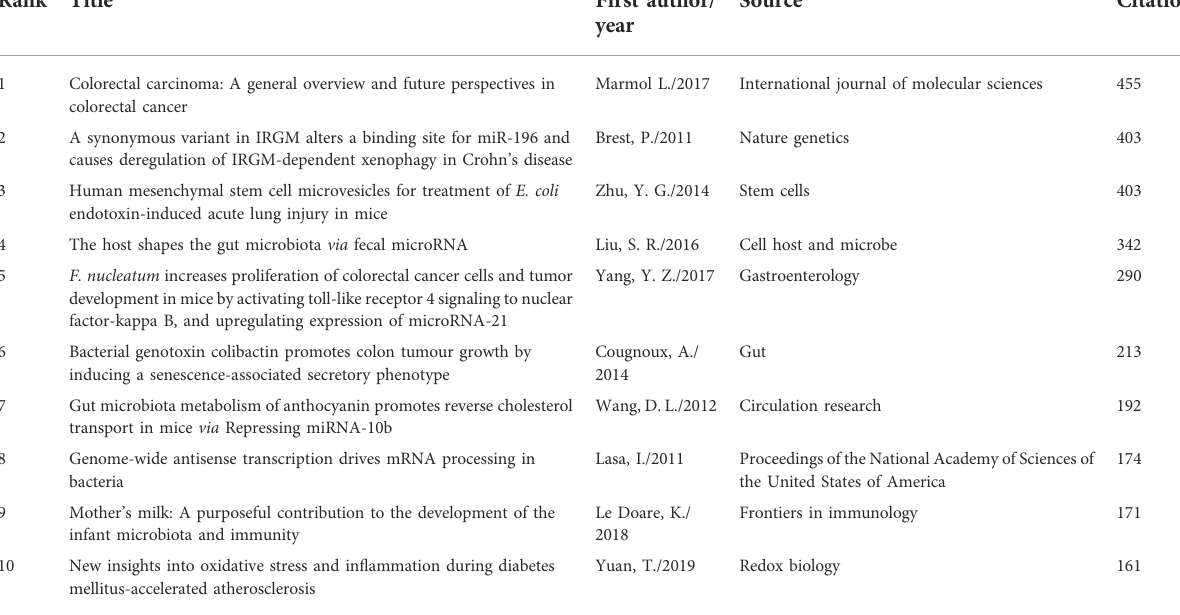
TABLE 3 Top ten citation analysis of documents on miRNA-microbiome interaction